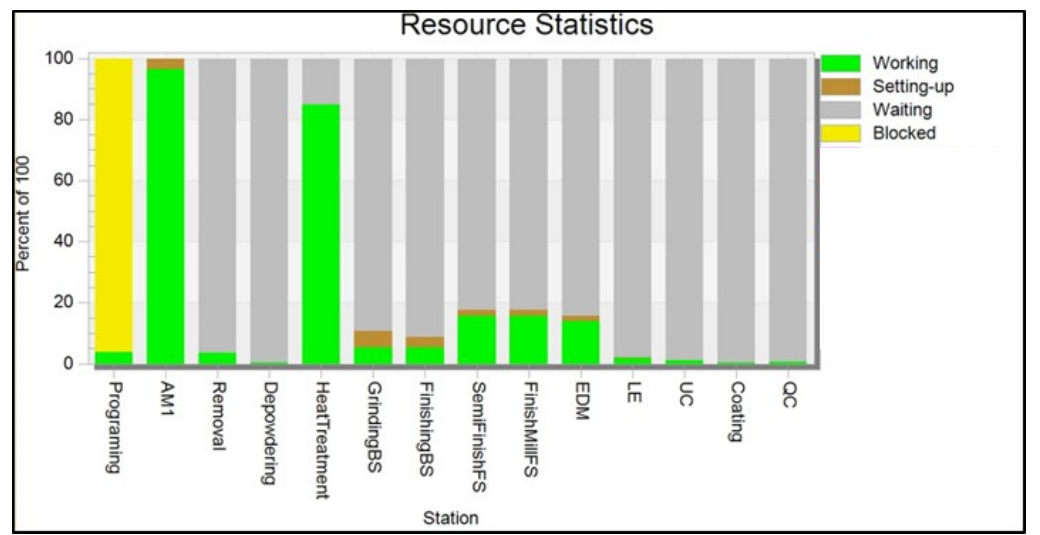
Figure 6. Resource statistics simulation for the AM workflow. The number of inserts produced in one year is 105.